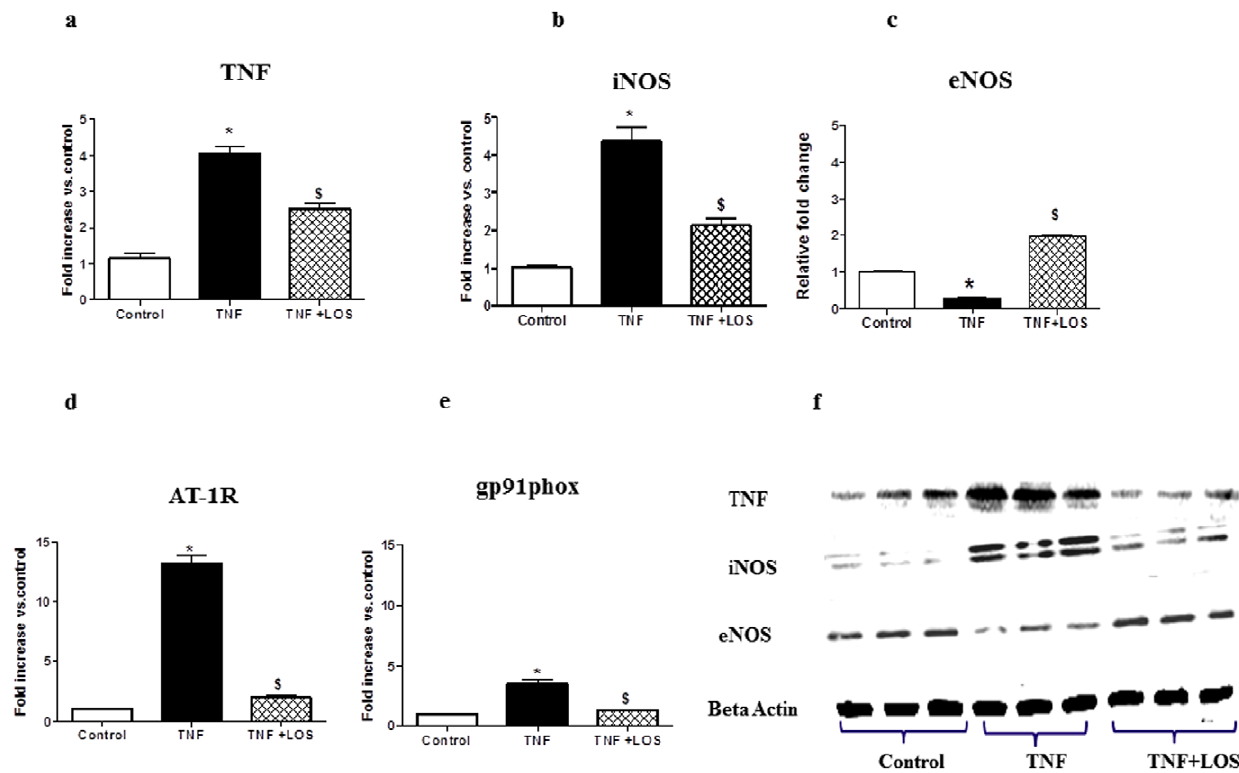
Figure 2. Effects of losartan treatment on mRNA expression of gene expression levels for a) TNF, b) iNOS, c) eNOS, d) AT-1R, and e) gp91phox as determined by real-time RT-PCR and protein expression levels of TNF, iNOS, and eNOS were measured by western blotting (Fig. 2f). Administration of TNF to rats induced significant increases in expression of proinflammatory and oxidative stress genes. Losartan attenuated these increases, thereby suggesting that TNF interacts with ANGII to cause some of its effects. * p , 0.05 vs. control; $ p , 0.05 vs.TNF.